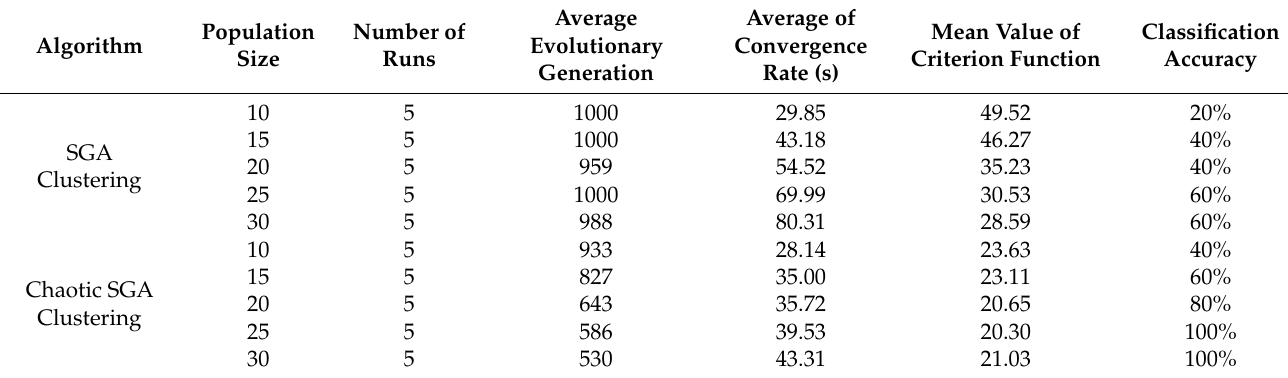
Table 2. Performance evaluation of SGA and chaotic SGA clustering under different population